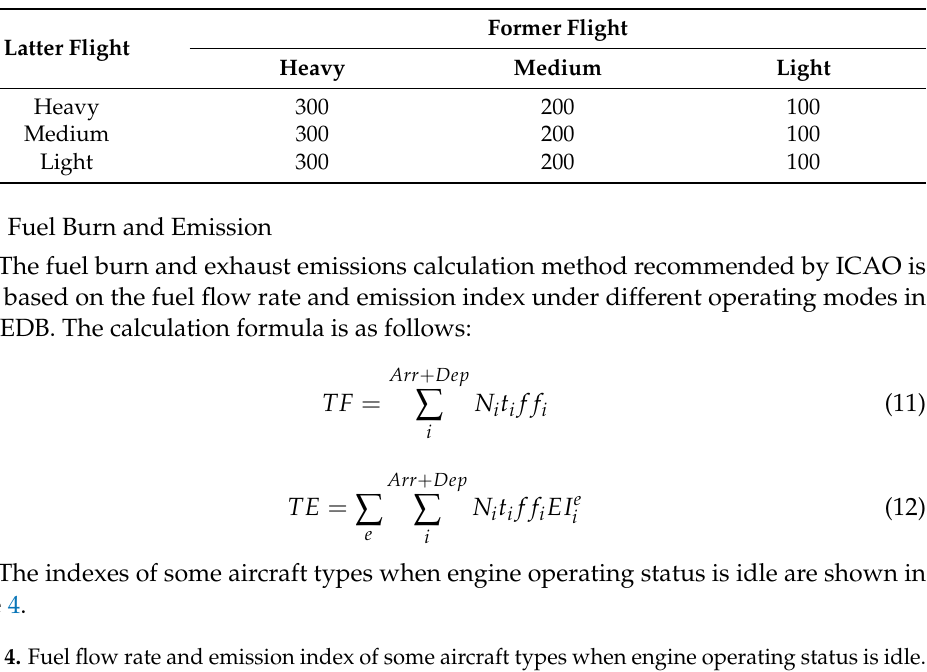
Table 3. Minimum safety separation standards (unit: meter).